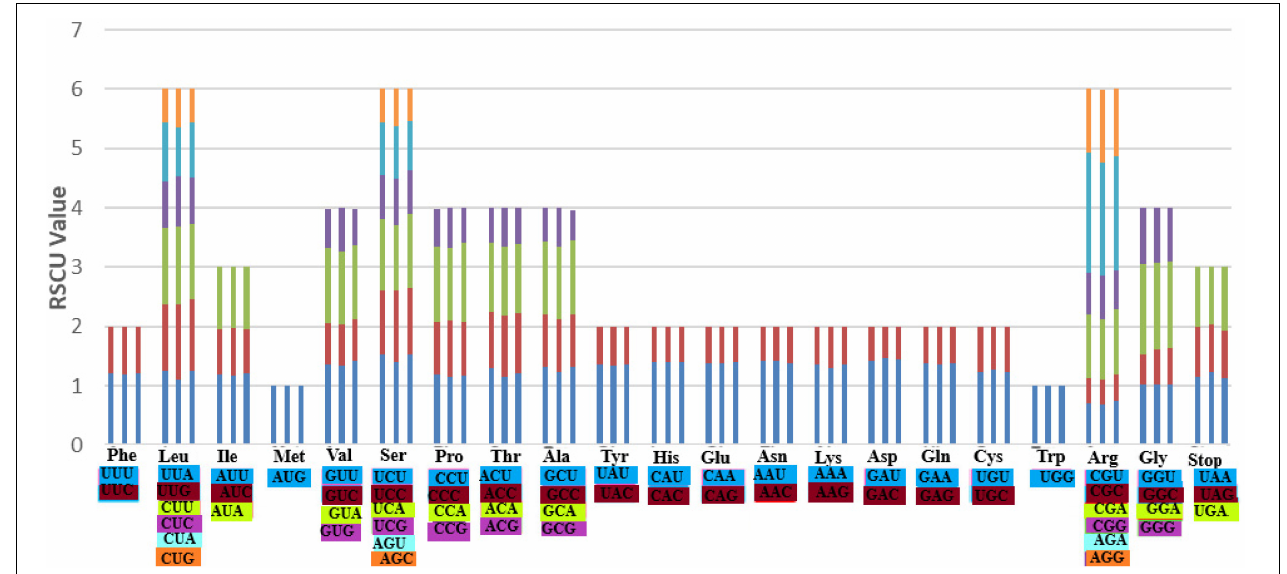
FIGURE 4 | The codon usage bias in all the protein-coding genes of the chloroplast genomes of the three species A. bracteata , X. spekei , and X. viscosa .